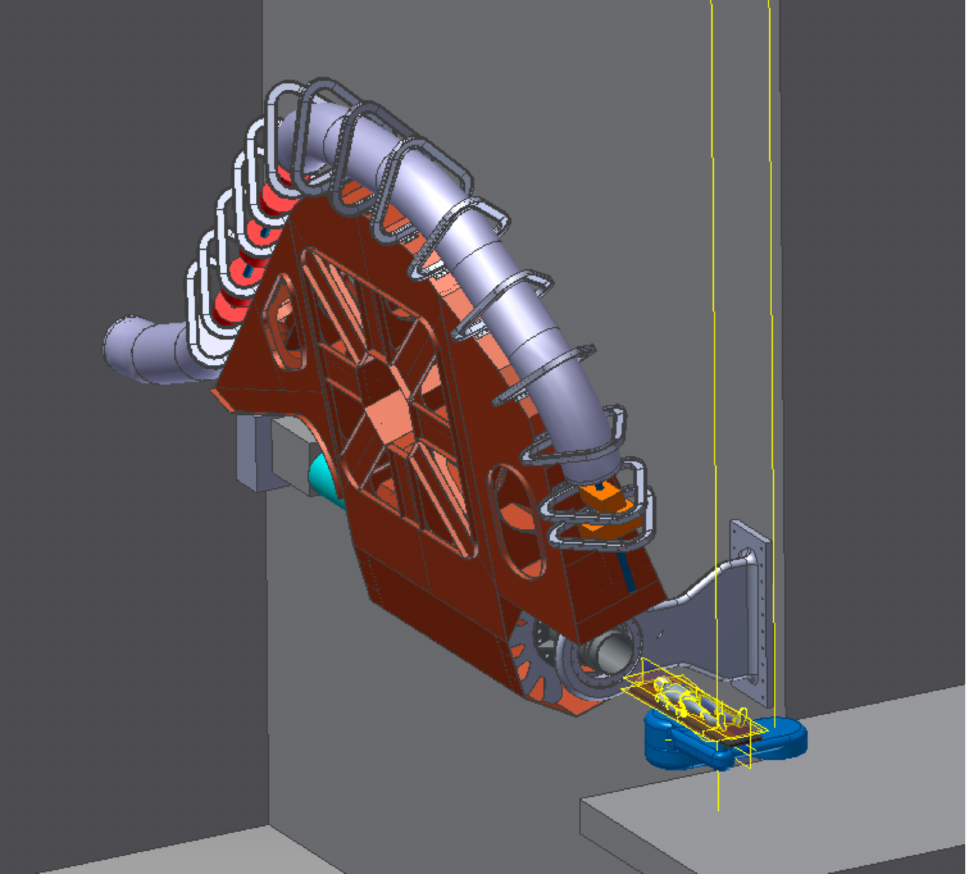
Figure 3. Schematic image of a compact gantry, with 180 ◦ rotation, designed within the collaboration activity performed by CERN-CNAO-INFN-MedAustron working